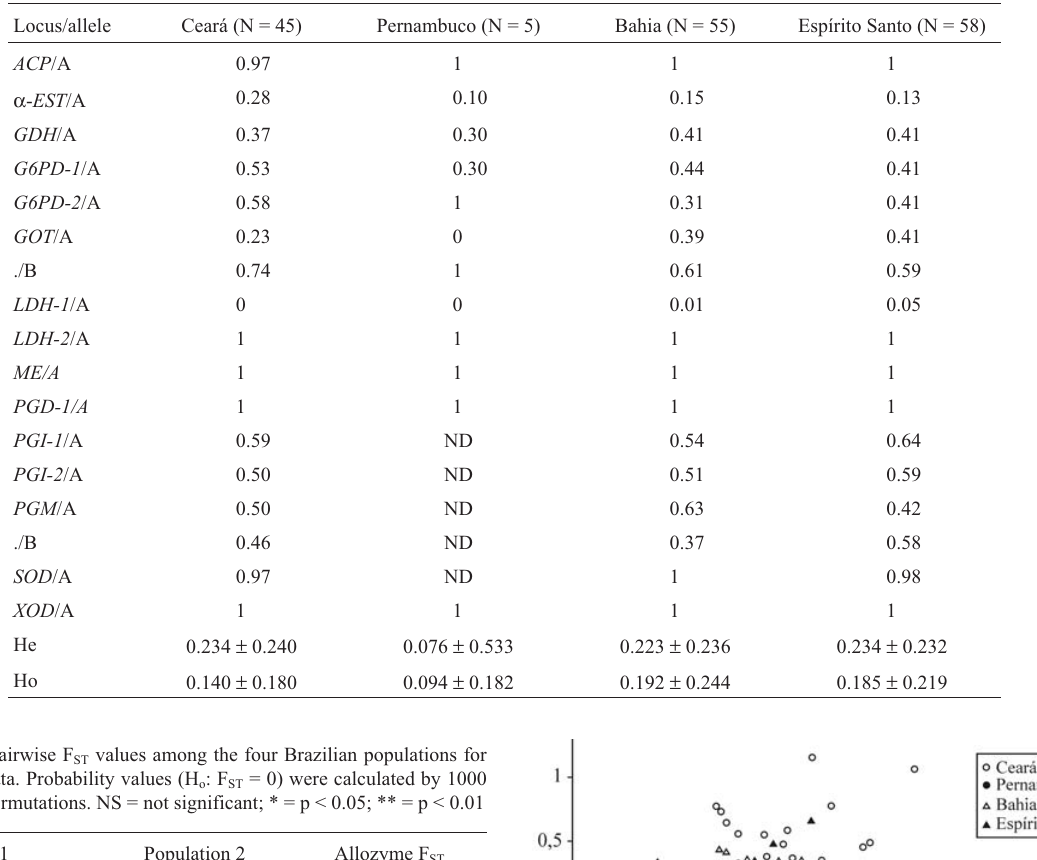
Table 3 - Allele frequencies for the 14 loci analysed. For simplicity, the slowest migrating allele for each locus is not shown: its frequency can be calcu- lated as one minus the frequency of the other alleles at that locus in the population. N = number of individuals analysed; He = mean Hardy-Weinberg ex- pected heterozygosity; Ho = mean observed heterozygosity (values shown as average ± standard error) Locus/allele